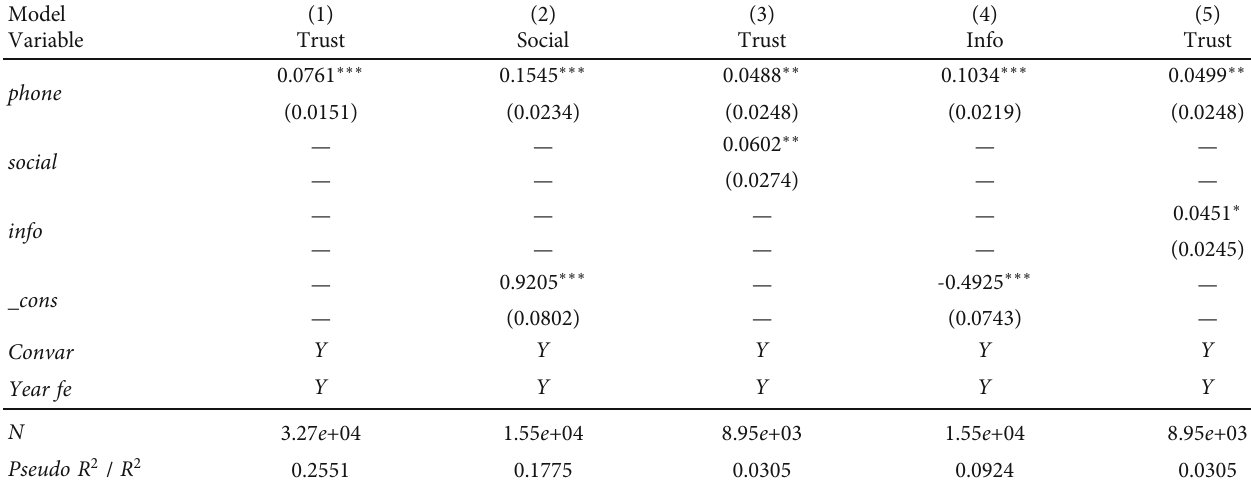
Table 8: Mechanism test